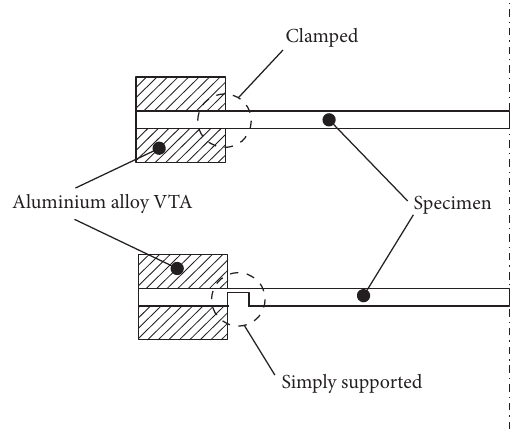
Figure 4: Drawing of clamped and simply supported BC.